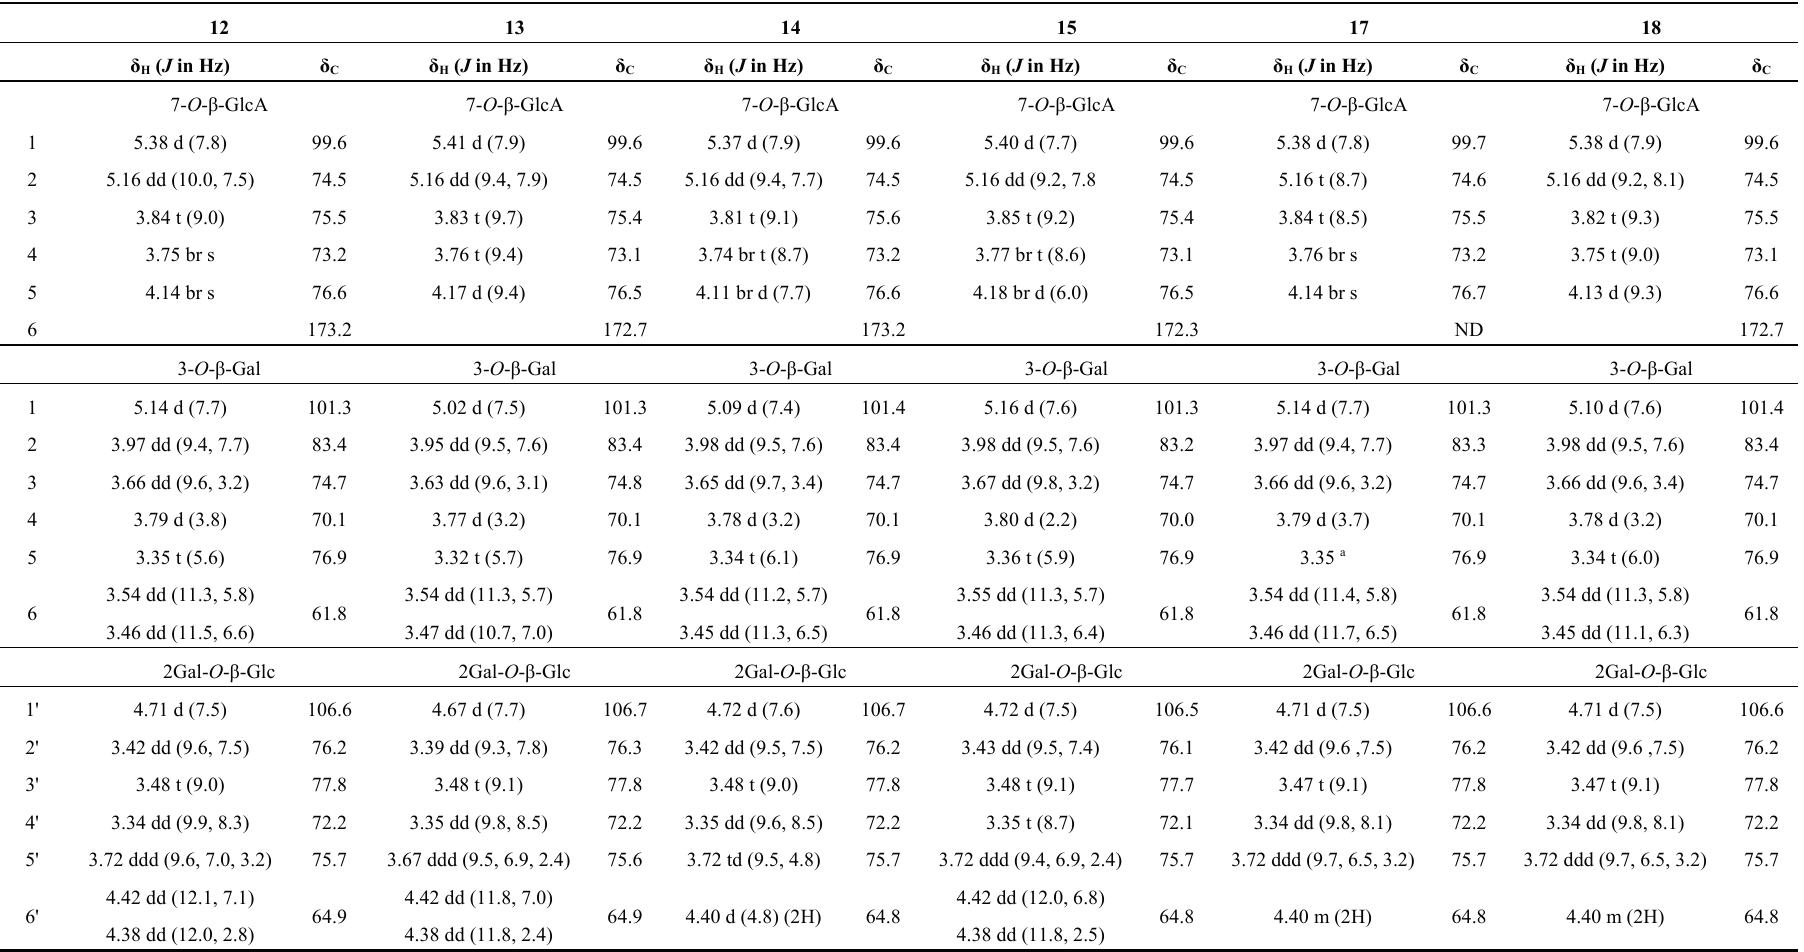
Table 4. NMR spectroscopic data (methanol- d 4 , 500 MHz) for the sugar and phenolic acid units of compounds 12 – 15 , 17 and 18